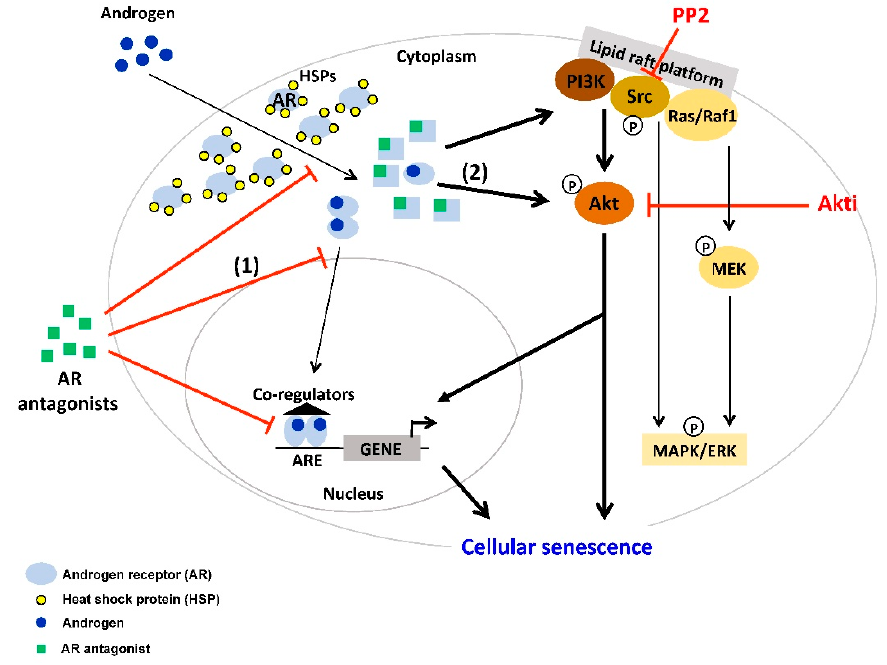
Figure 2. AR antagonist induces cellular senescence in PCa through the Src / Akt pathway. Binding of AR antagonist to AR leads to conformational change of AR. AR antagonists compete with androgens for binding to AR. (1) Moreover, some AR antagonists reduce AR nuclear translocation, chromatin association and DNA binding. (2) As a result, the majority of AR resides in the cytoplasm and may interact with cytoplasmic factors to mediate cellular senescence. Co-treatment of the AR antagonist atraric acid with the inhibitors of Src (PP2) or Akt (Akti) reduce cell senescence suggesting that Src / Akt pathway is involved in AR antagonist-induced cellular senescence in PCa cells.